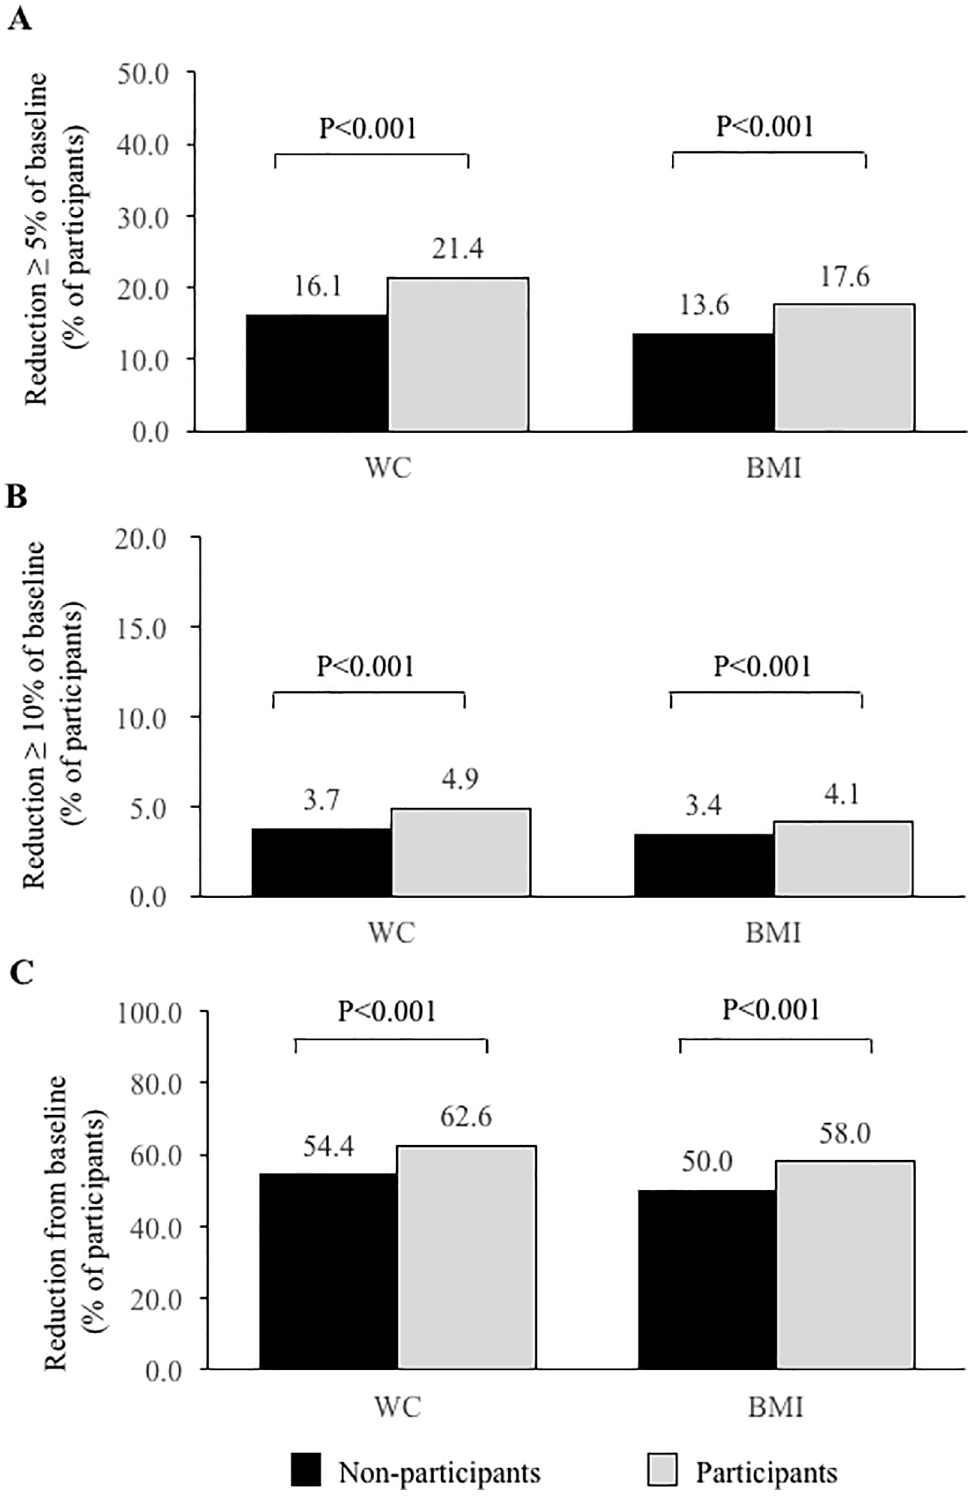
Fig 2. Categorical waist and weight reduction. WC, waist circumference; BMI, body mass index.